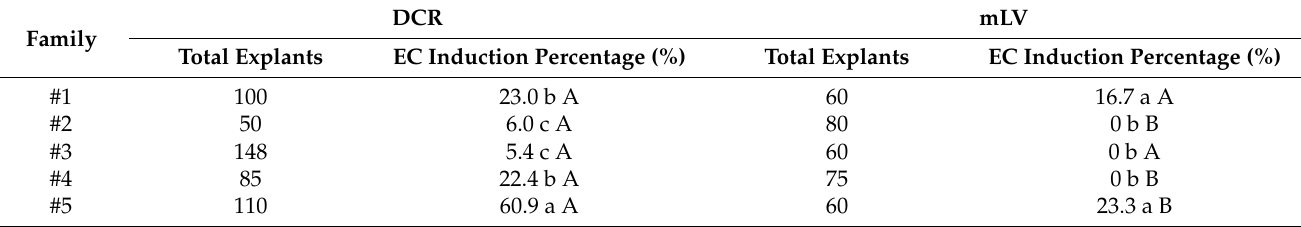
Table 3. Effect of basal medium on EC induction of Korean pine.